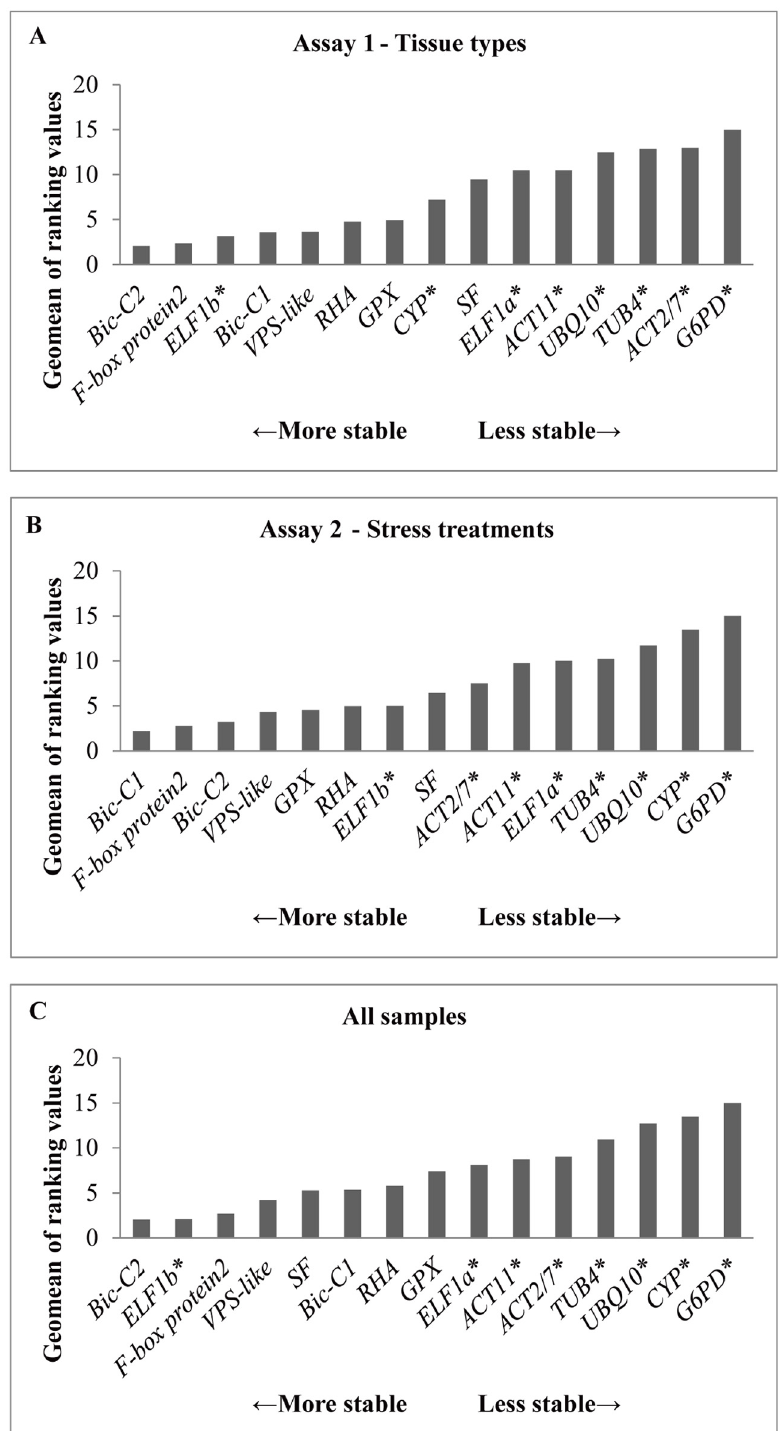
Fig 2. Geomeans of ranking values of (A) tissue types, (B) stress treatments, and (C) all samples. Genes are arranged in descending order of stability from left to right. Commonly used reference genes are marked with asterisk ( *